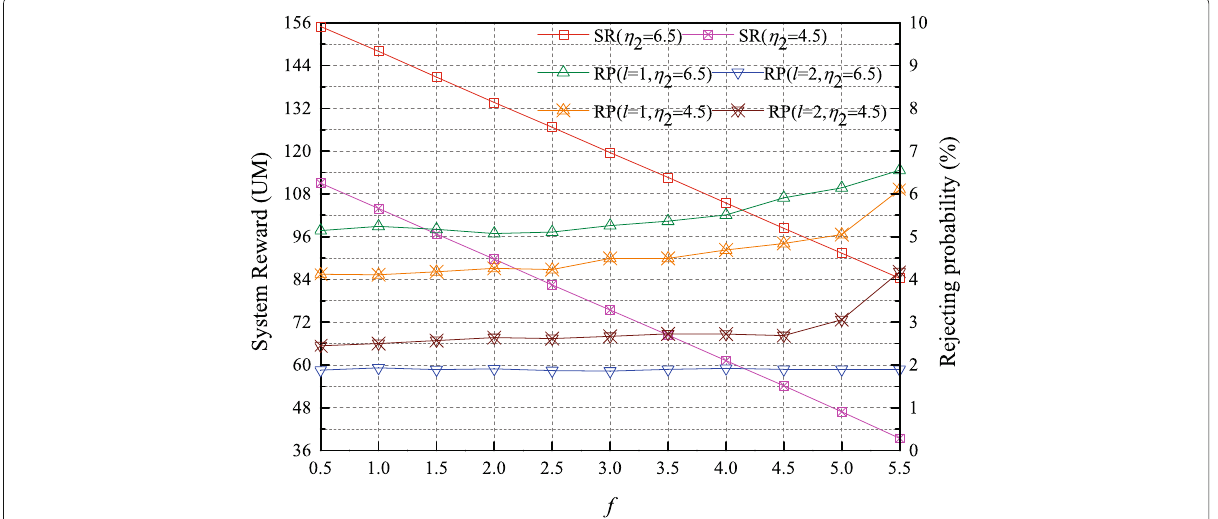
Fig. 15 SR and RPs under different f . This figure shows the impacts of the resource occupation cost coefficient( f ) on the evaluation